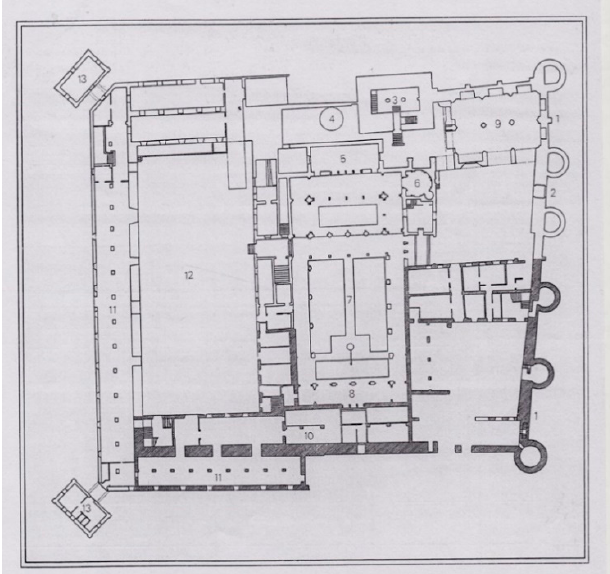
Figure 37. Ground plan of the Aljafería (Zaragoza, Spain), with the chapels of St Martin (9) and St George (10). Source: (Expósito Sebastián et al.